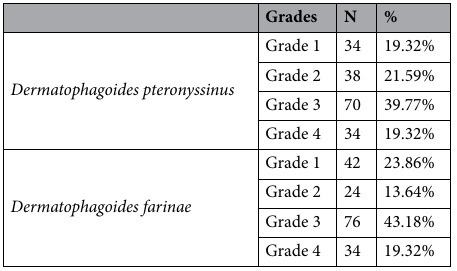
Table 5. Grades of the SPT results in case group. Grade 1 is 25% of area of histamine-induced wheal, Grade 2 is 50% of this area, Grade 3 is 100% of this area, Grade 4 is 200% of